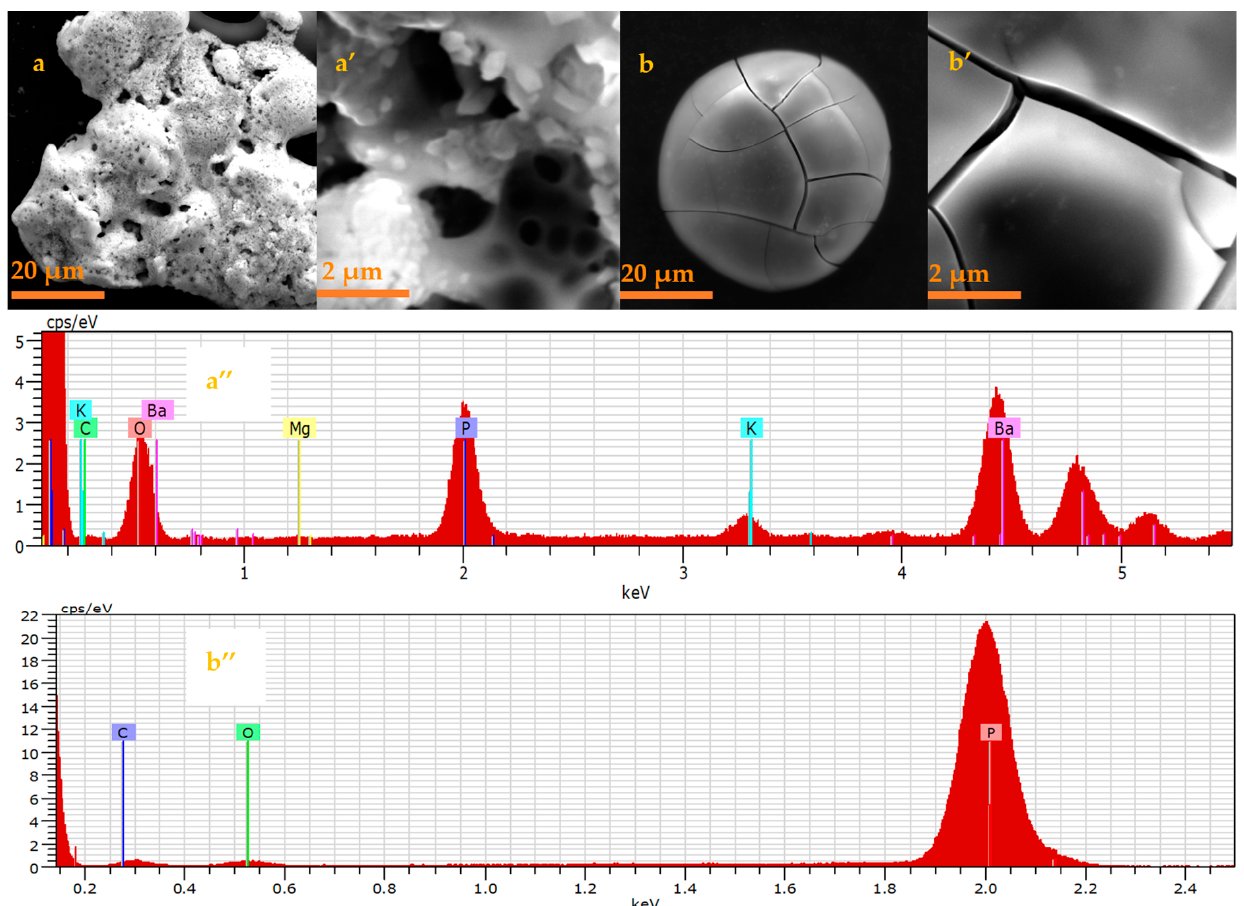
Figure 4. SEM images of resulting solid particle and the corresponding EDS spectra: ( a )—porous shape of phosphorus and barium particle; ( a’ )—submicron cracks in the phosphorus and barium particle; ( b )—spherical form of phosphorus and oxygen particle; ( b’ )—submicron cracks in the phosphorus and oxygen particle; ( a” )—Phosphorus and barium particle; ( b” )—Phosphorus and barium particle.